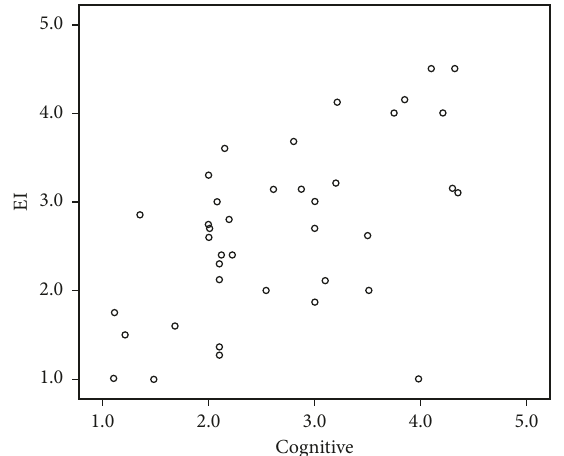
Figure 6: The relationship between emotional strategy use and cognitive strategy use.